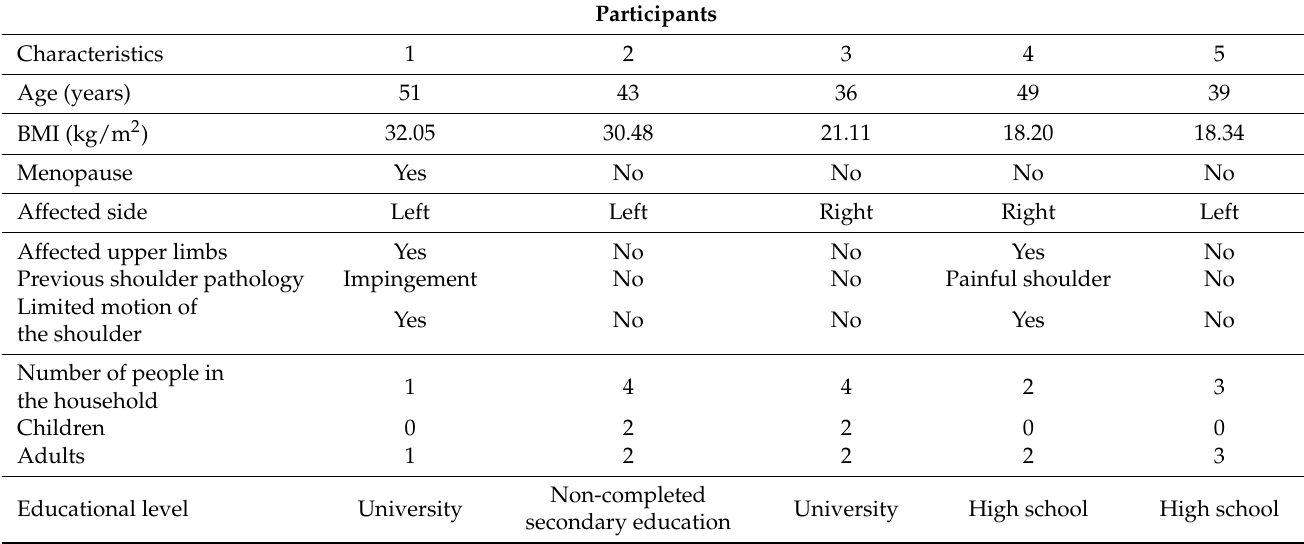
Table 1. Characteristics of the sample.